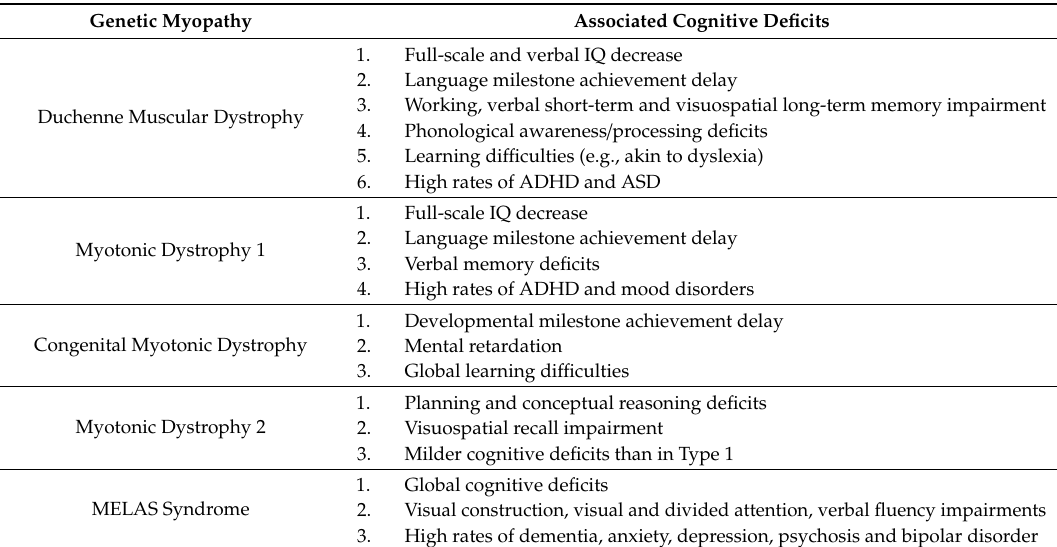
Table 1. Cognitive deficits reported in genetic